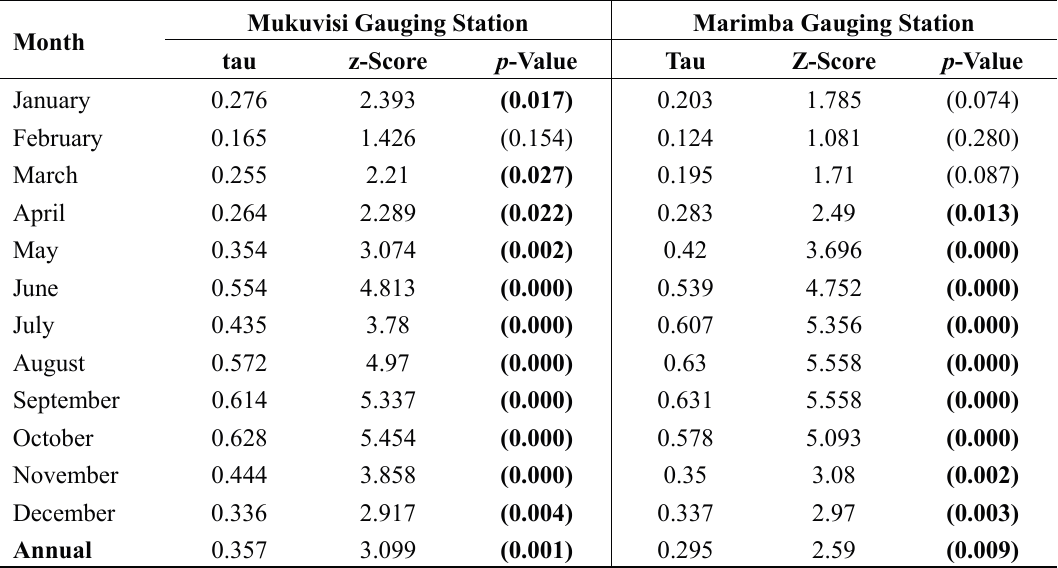
Table 7. The Kendall test statistic (tau) for trend analysis for annual and monthly streamflow measured from 1970 to 2008 at Marimba and Mukuvisi gauging stations. Statistically significant trends ( p < 0.05) are shown in